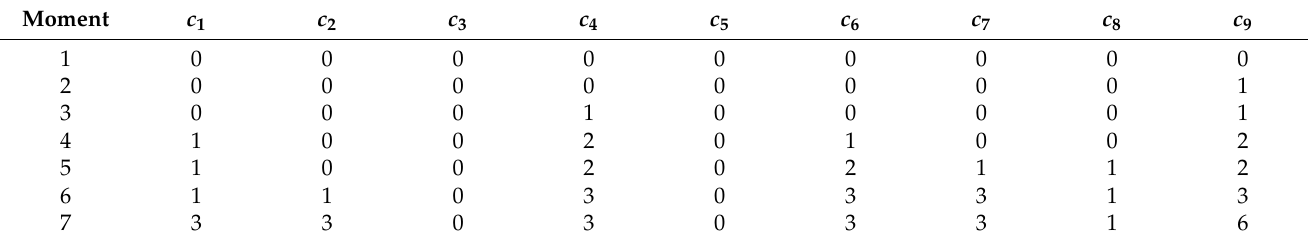
Table 9. Characteristic quantity sequence at moments 1–7.